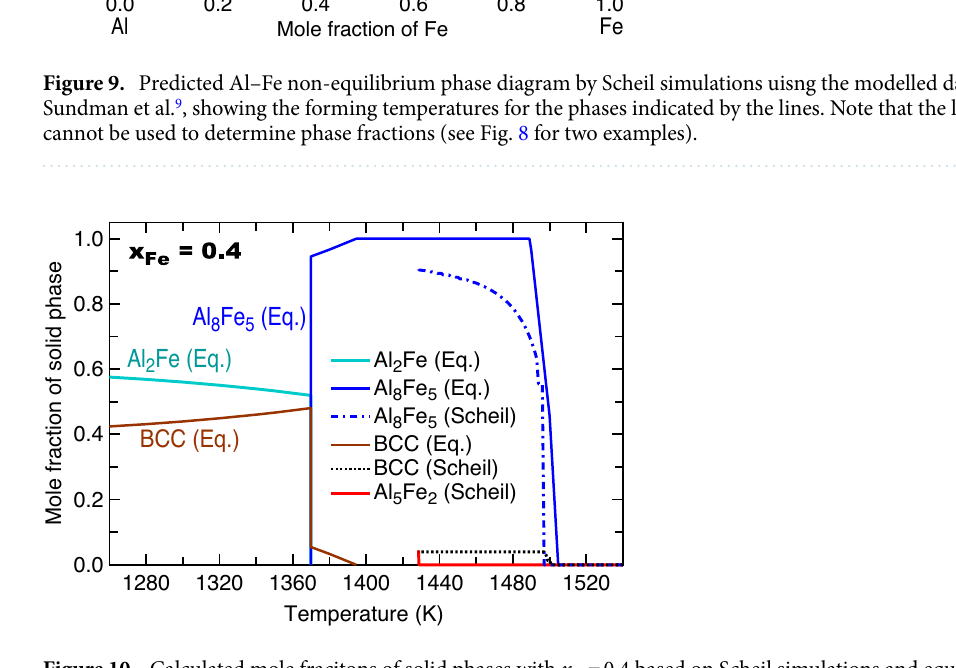
Figure 10. Calculated mole fracitons of solid phases with x Fe = 0.4 based on Scheil simulations and equilibrium (Eq.) calculations using the modelled data by Sundman et al. 9